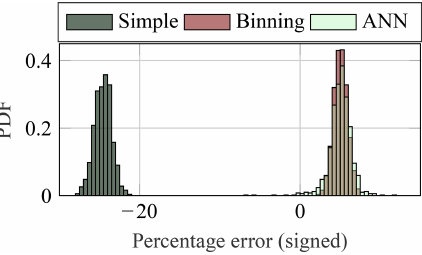
Figure 21. Empirical distribution for the (signed) percentage er- ror of predicted yearly damage using different extrapolation meth- ods. Prediction from a single year (1 August 2016 to 31 July 2017) to another year (1 October 2015 to 31 July 2016 and 1 August to 30 September 2017). PDF: probability density